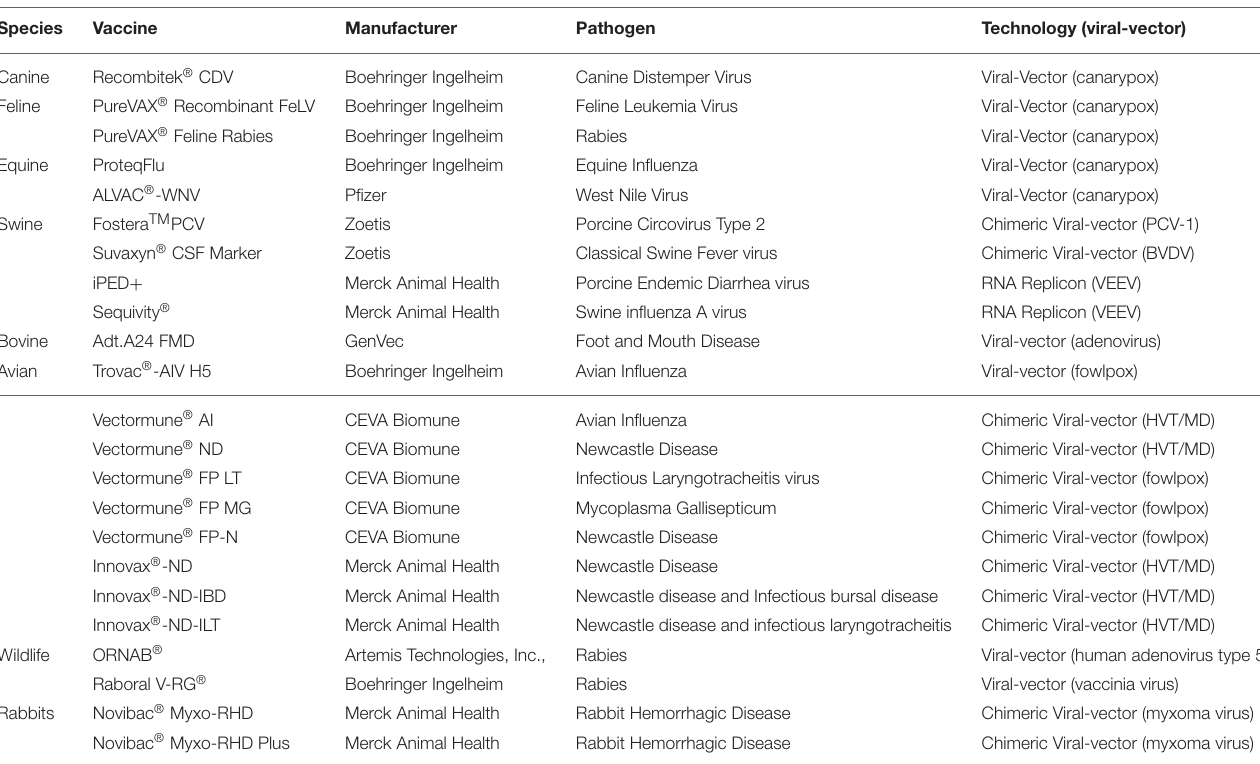
TABLE 3 | Recombinant viral vector